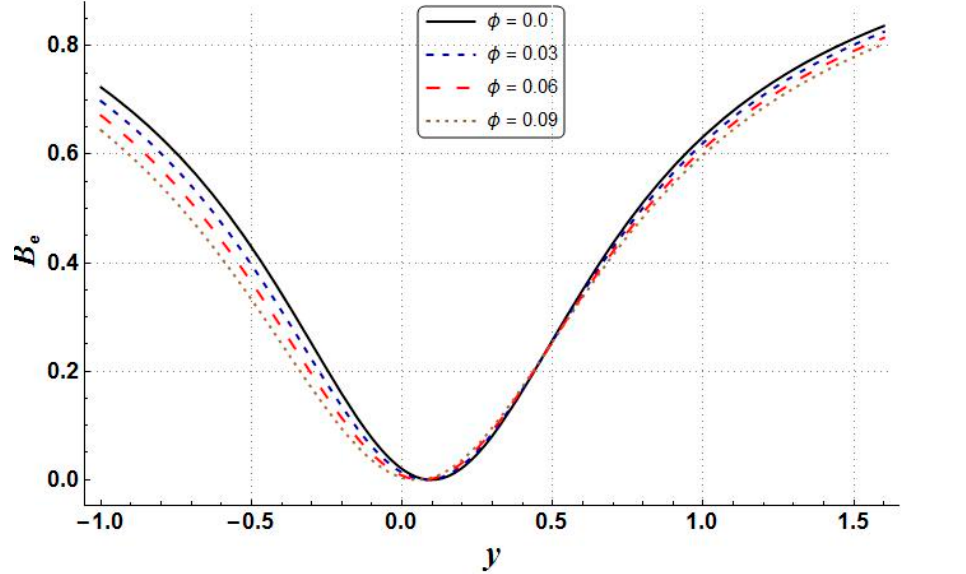
, x = 0, Gr = 2, α = π , 4 4 Br , where